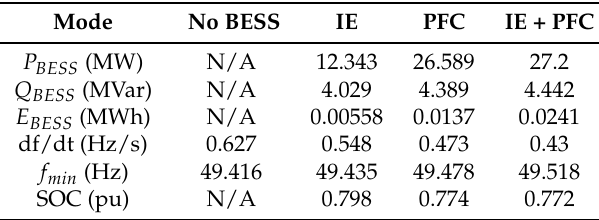
Figure 7. The frequency (pu) oscillation of generators with the load event. Table 1. The frequency results of G1 with the load